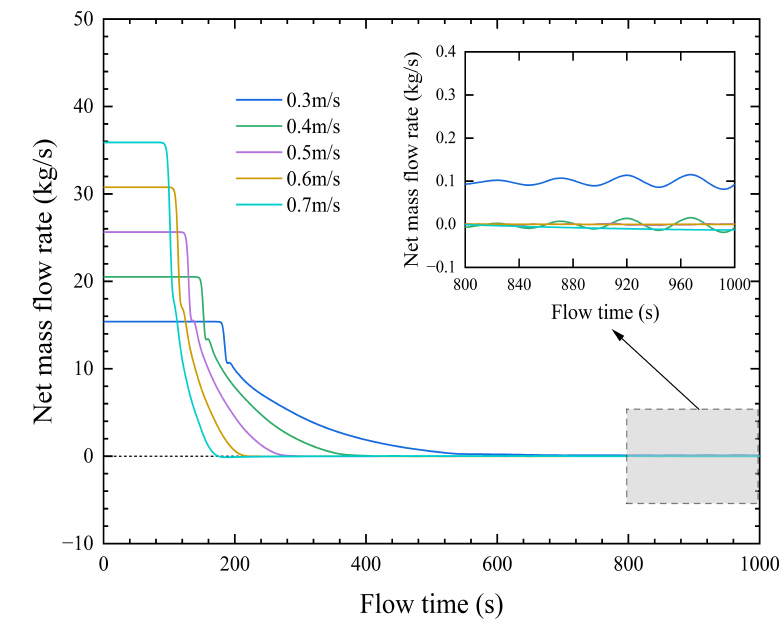
Figure 3. Net mass flow rate changes with flow time (horizontal pipe L = 80 m d = 0.02